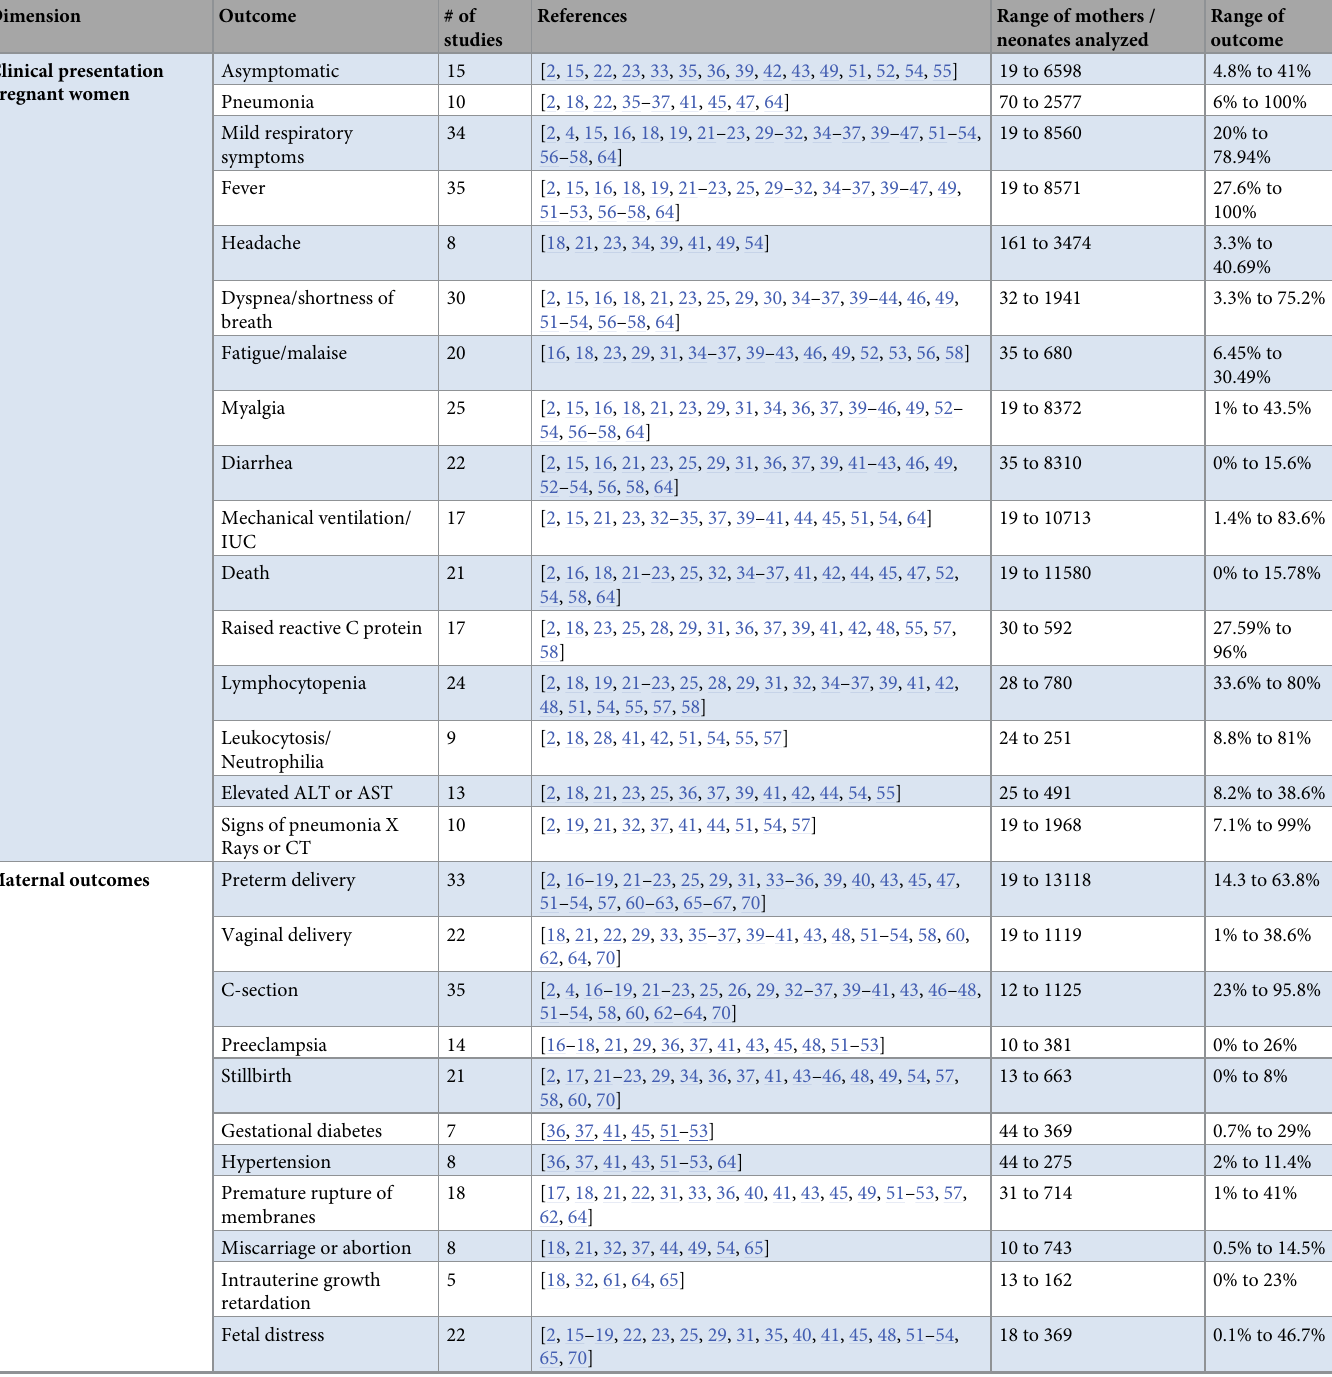
Table 2. Ranges of outcomes reported in the included systematic reviews � .